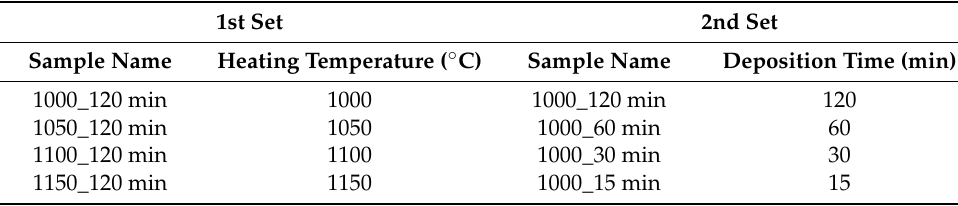
Table 1. Two sub-series of experiments took place during the chromizing